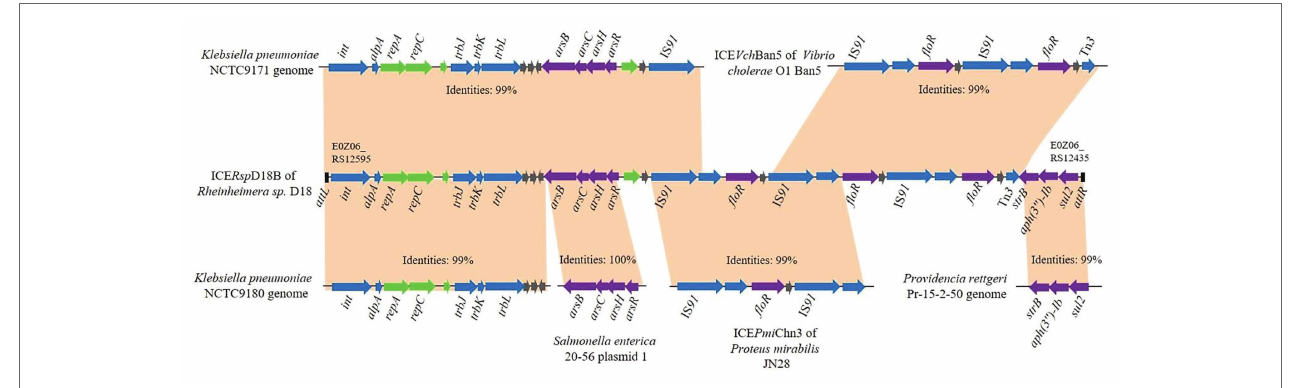
FIGURE 2 | Schematic representation of the potential sources of genes in ICE Rsp D18B. Pairwise alignment of ICE Rsp D18B of Rheinheimera sp. D18 with closely related DNA sequences from ICE Vch Ban5 of Vibrio cholerae O1 Ban5, ICE Pmi Chn3 of Proteus mirabilis JN28, plasmid 1 of Salmonella enterica 20–56, and the Klebsiella pneumoniae NCTC9171, K. pneumoniae NCTC9180, and Providencia rettgeri Pr-15-2-50 genomes. Genes are indicated by arrows, and colors represent the following predicted functions: violet, arsenic, or antibiotic resistance; blue, conjugative transfer; green, DNA replication or partitioning; and gray, other functions. Orange shading matches regions with high sequence